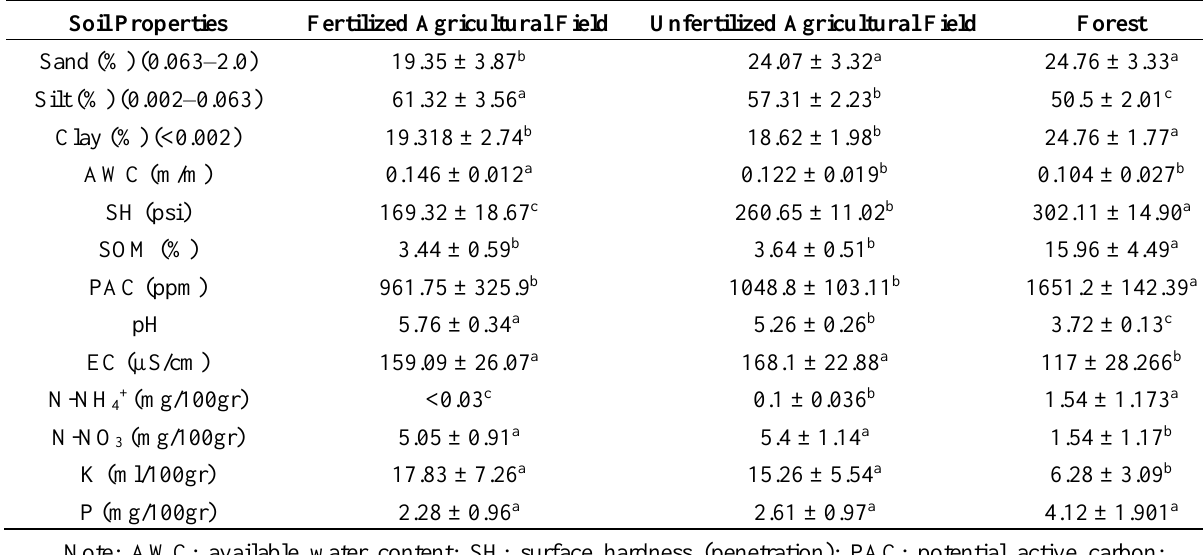
Table 3. Soil quality properties for the Schäfertal site, Germany, with the following treatments: (A) agriculture 1; (B) agriculture 2; and (C) forest. Statistics include: average value, standard deviation, and indication of significant differences between treatments. Soil Properties Sand (%) (0.063–2.0)